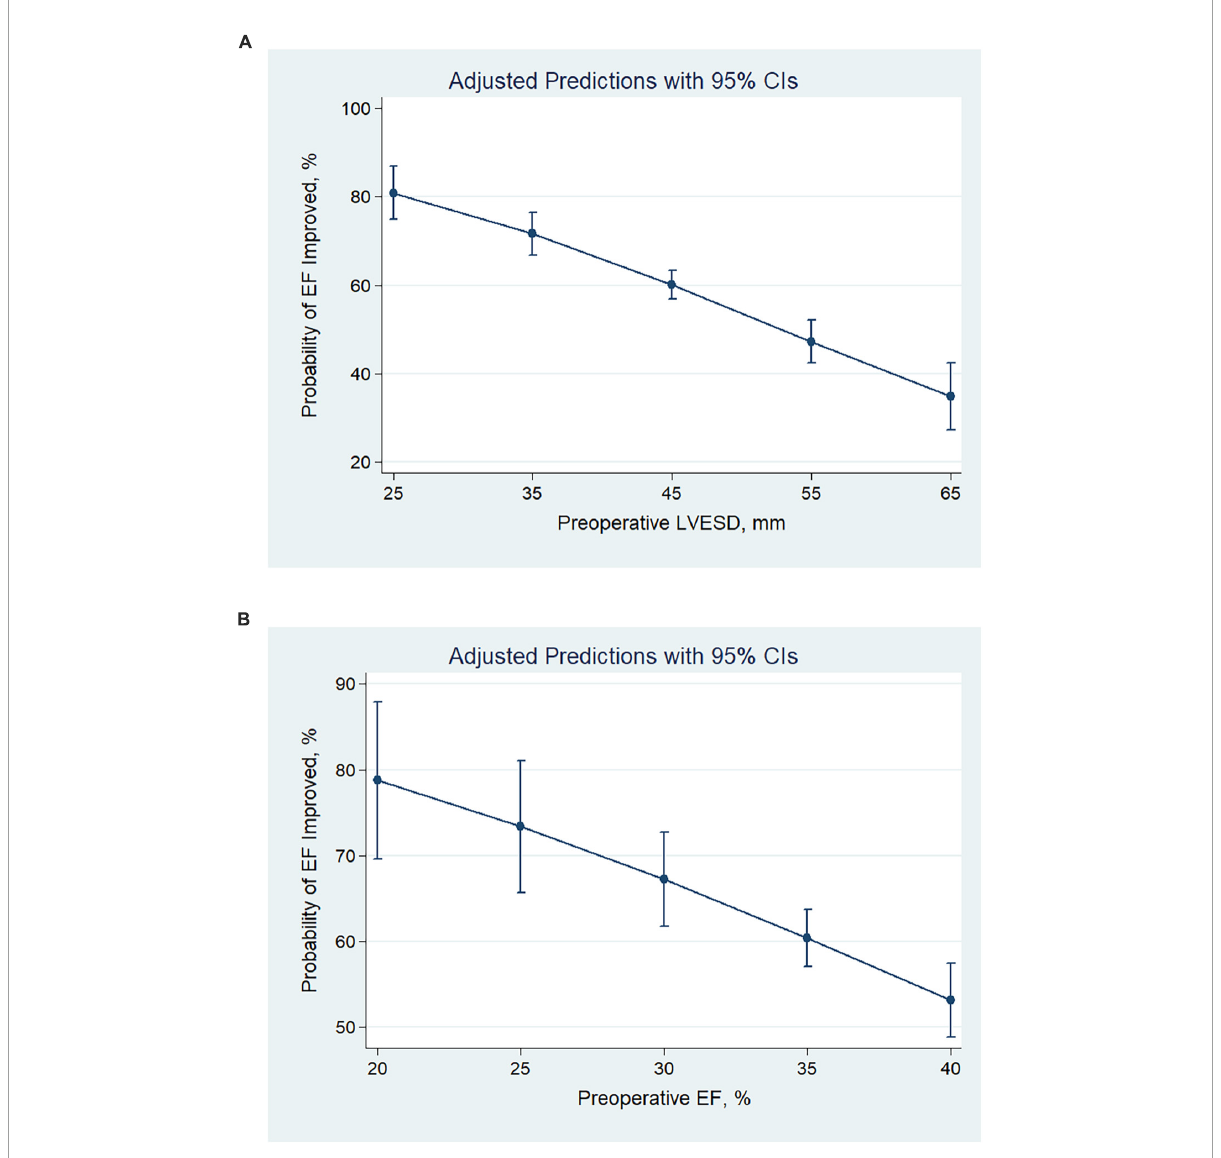
FIGURE1 Predicted probabilities and the 95% confidence interval of EF improvement after revascularization at different values of pre-operative LVESD (A) and EF (B) . With the decrease in pre-operative LVESD or EF, the probability of EF improvement increased. CI, confidence interval; LVESD, left ventricular end-systolic diameter; EF, ejection fraction.